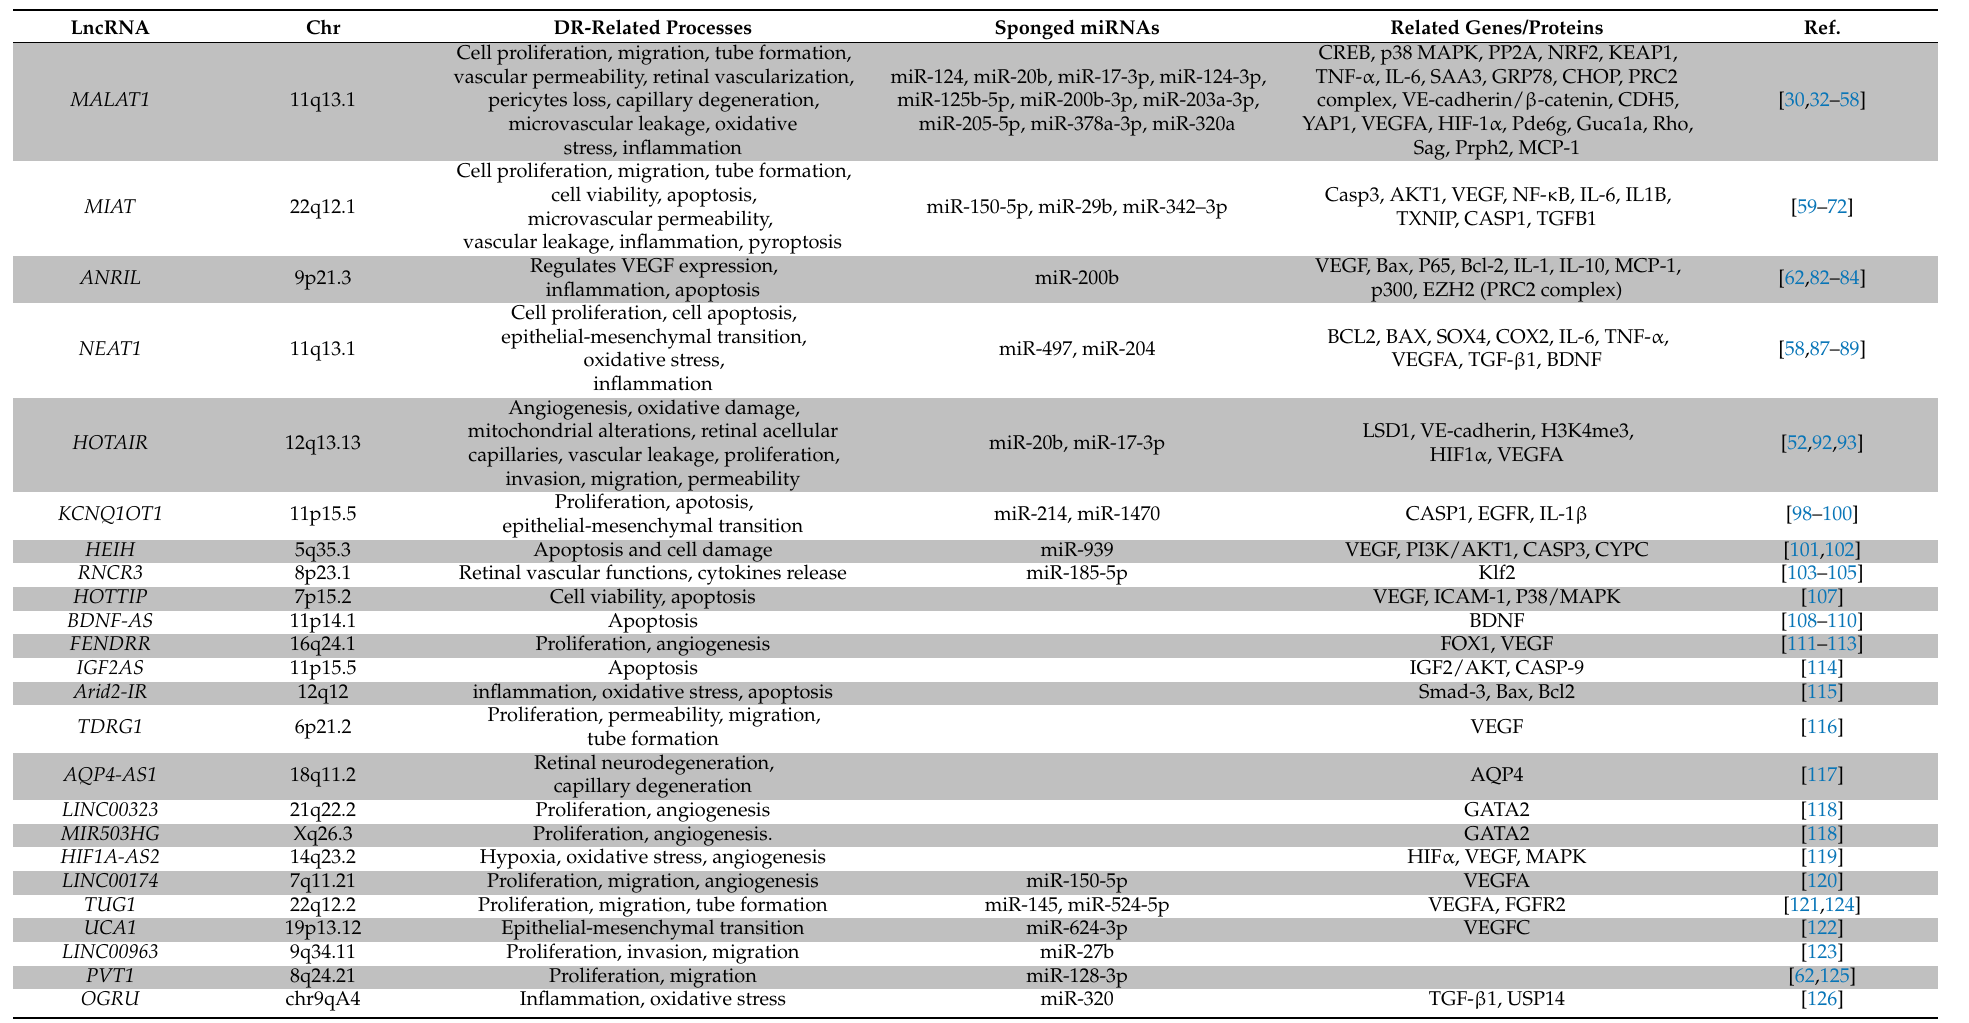
Table 1. Long non-coding RNAs reported as upregulated in diabetic